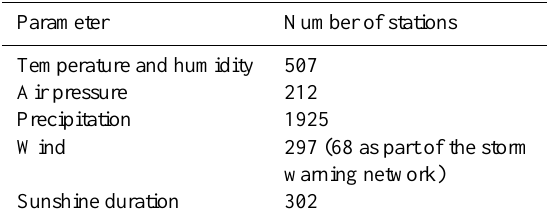
Table 2. Number of stations of the total network of DWD (the 35 stations of the Bundeswehr Geoinformation Service included) mea- suring specific